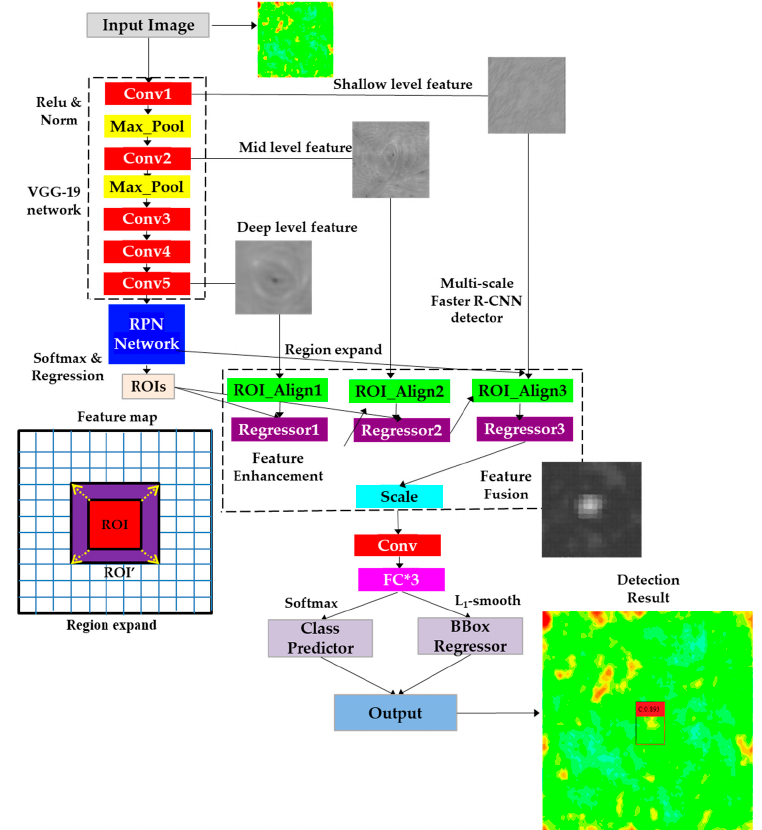
Figure 1. The flow chart of internal crack detection using MSE-Faster R-CNN.